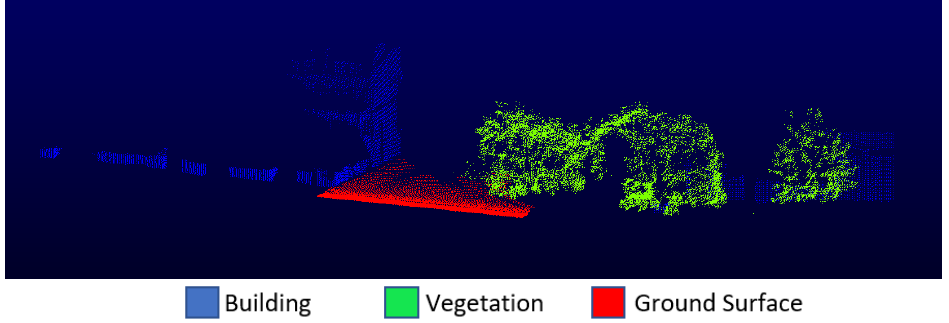
Figure 3. Training and test samples from Vaihingen dataset. ( a ) Training sample. ( b ) Test sample.